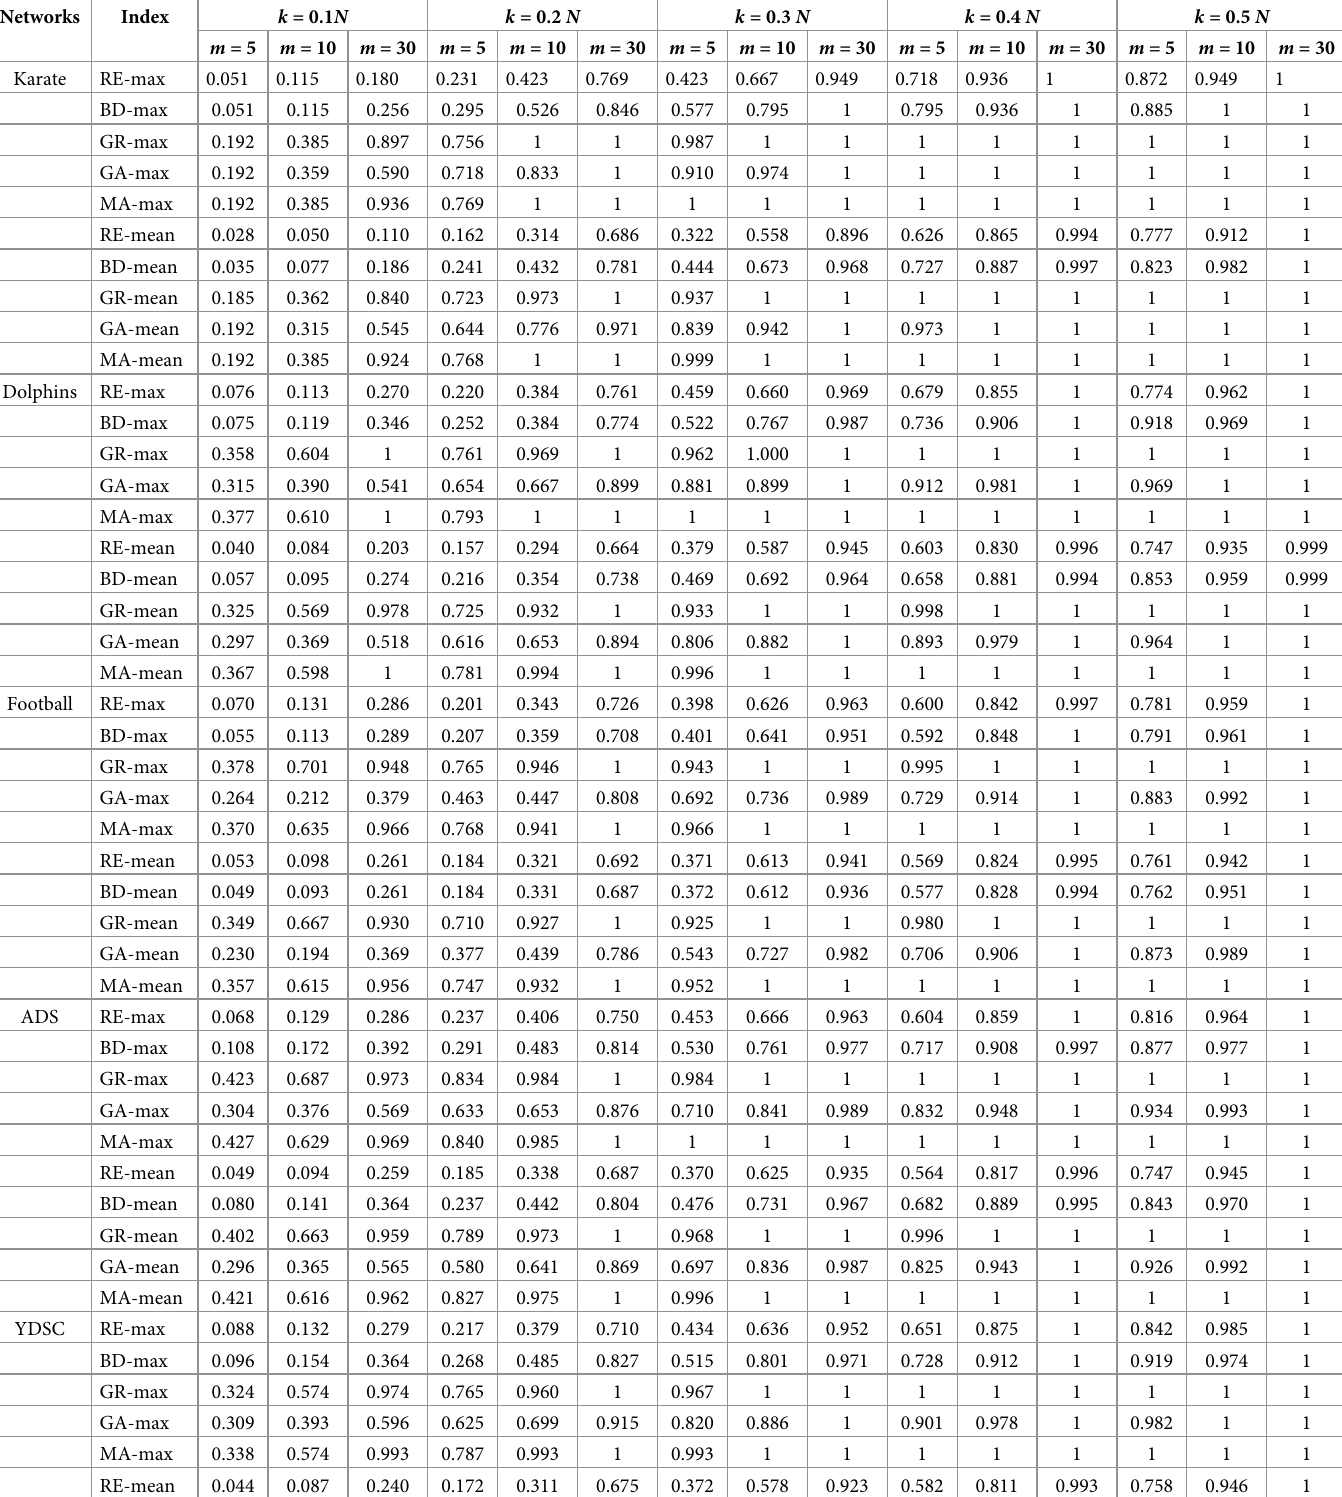
Table 2. Mean and maximum values of the covering for the real-world networks.